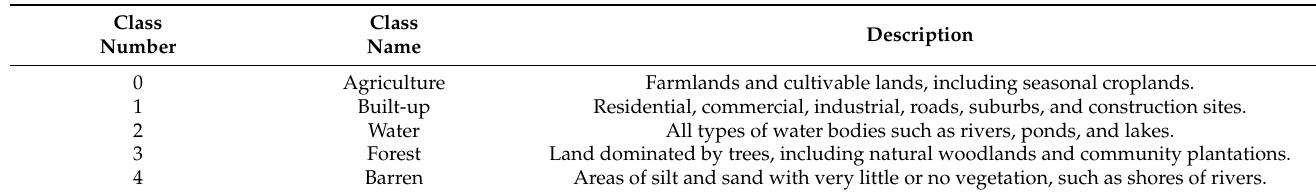
Table 1. Description of land cover classes used in the